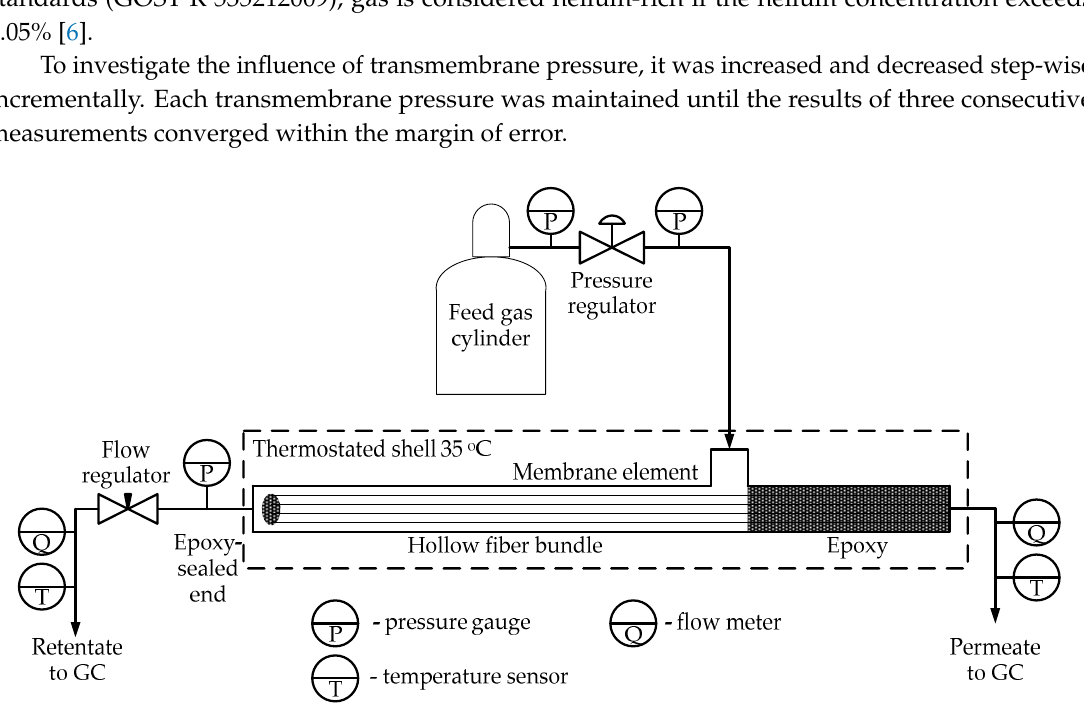
Table 1. The influence of spinning parameters on the hollow fiber’s geometrical and separation characteristics. OD—Outer diameter; ID—Internal diameter.